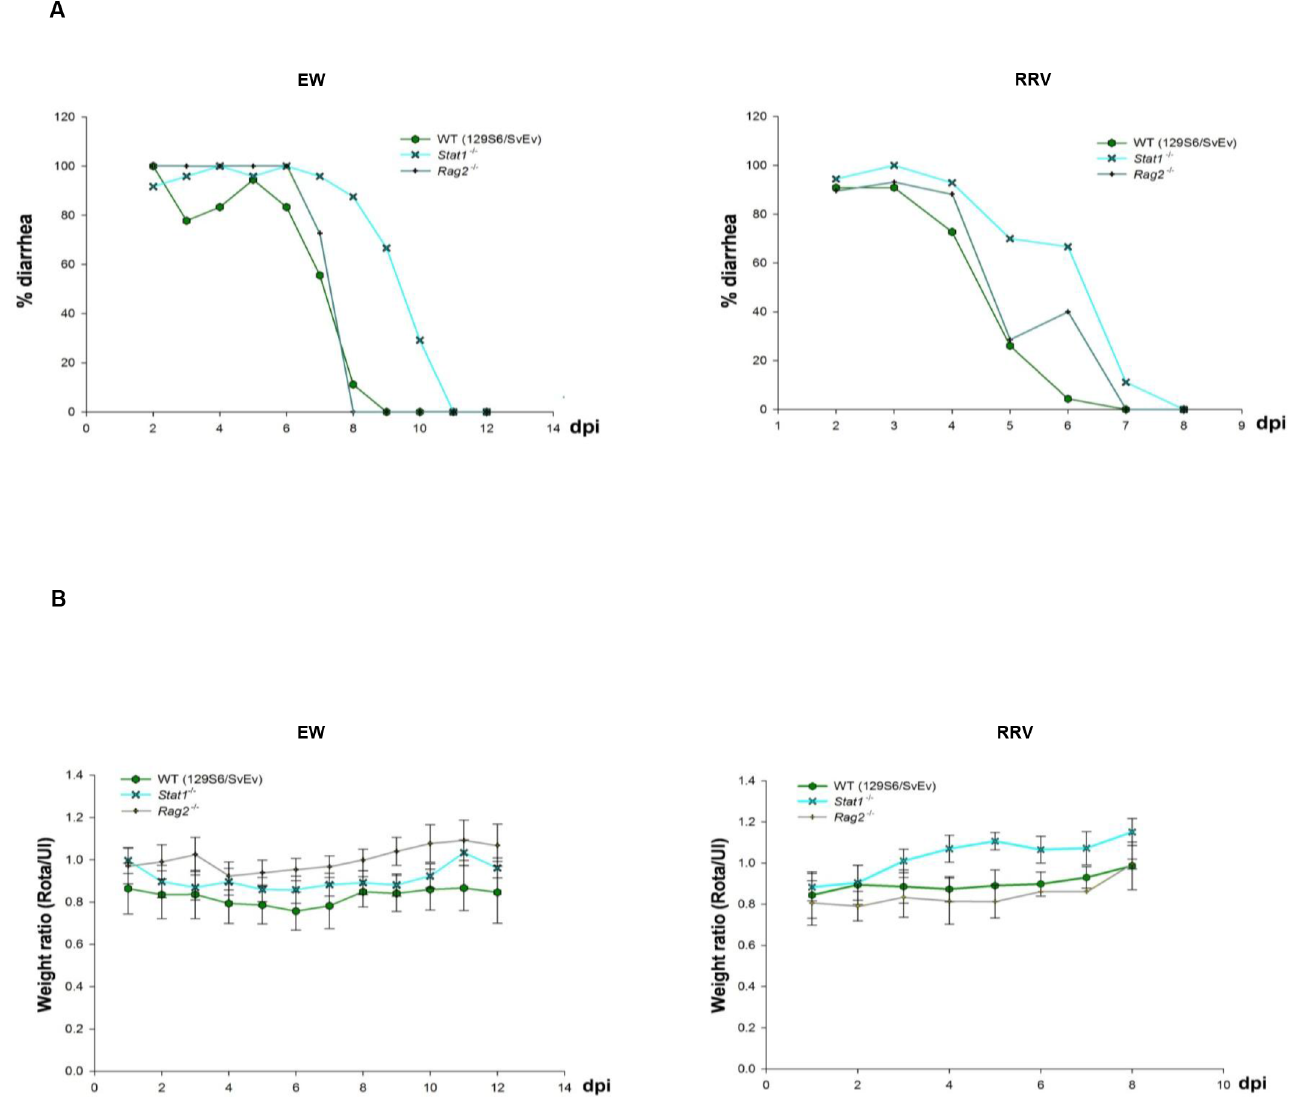
Fig 3. IFNs may affect diarrheal disease but not weight gain during RV infection. Eight-day-old suckling 129S6/SvEv, Stat1 -/- and Rag2 -/- (on 129S6/ SvEv background) mice (n = 6 – 10) were orally infected with 10 4 DD 50 EW-RV or 4x10 6 FFU RRV. The variable sample number (n) reflects the variation